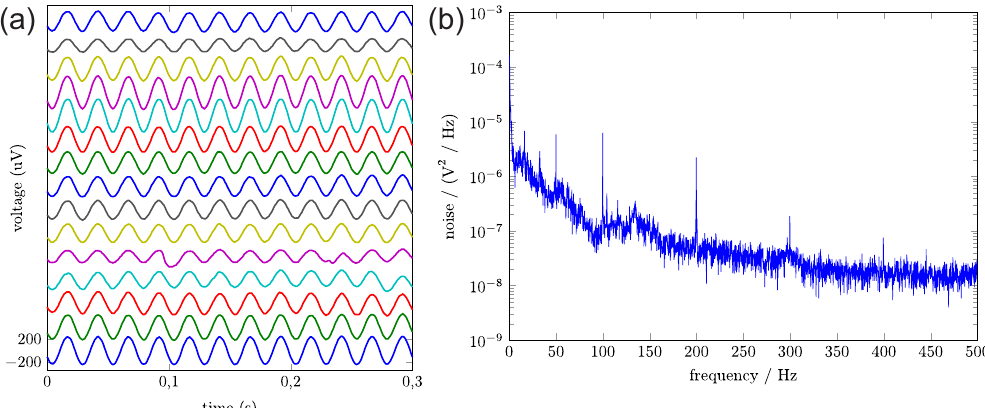
Figure 6. ( a ) received signals for a 40 Hz test signal. The amplitude depends on the distance between the stimulating wire and the channel electrode. The different channels are depicted in offset steps of 400 µ V; ( b ) noise spectrum for open inputs in the Ringer